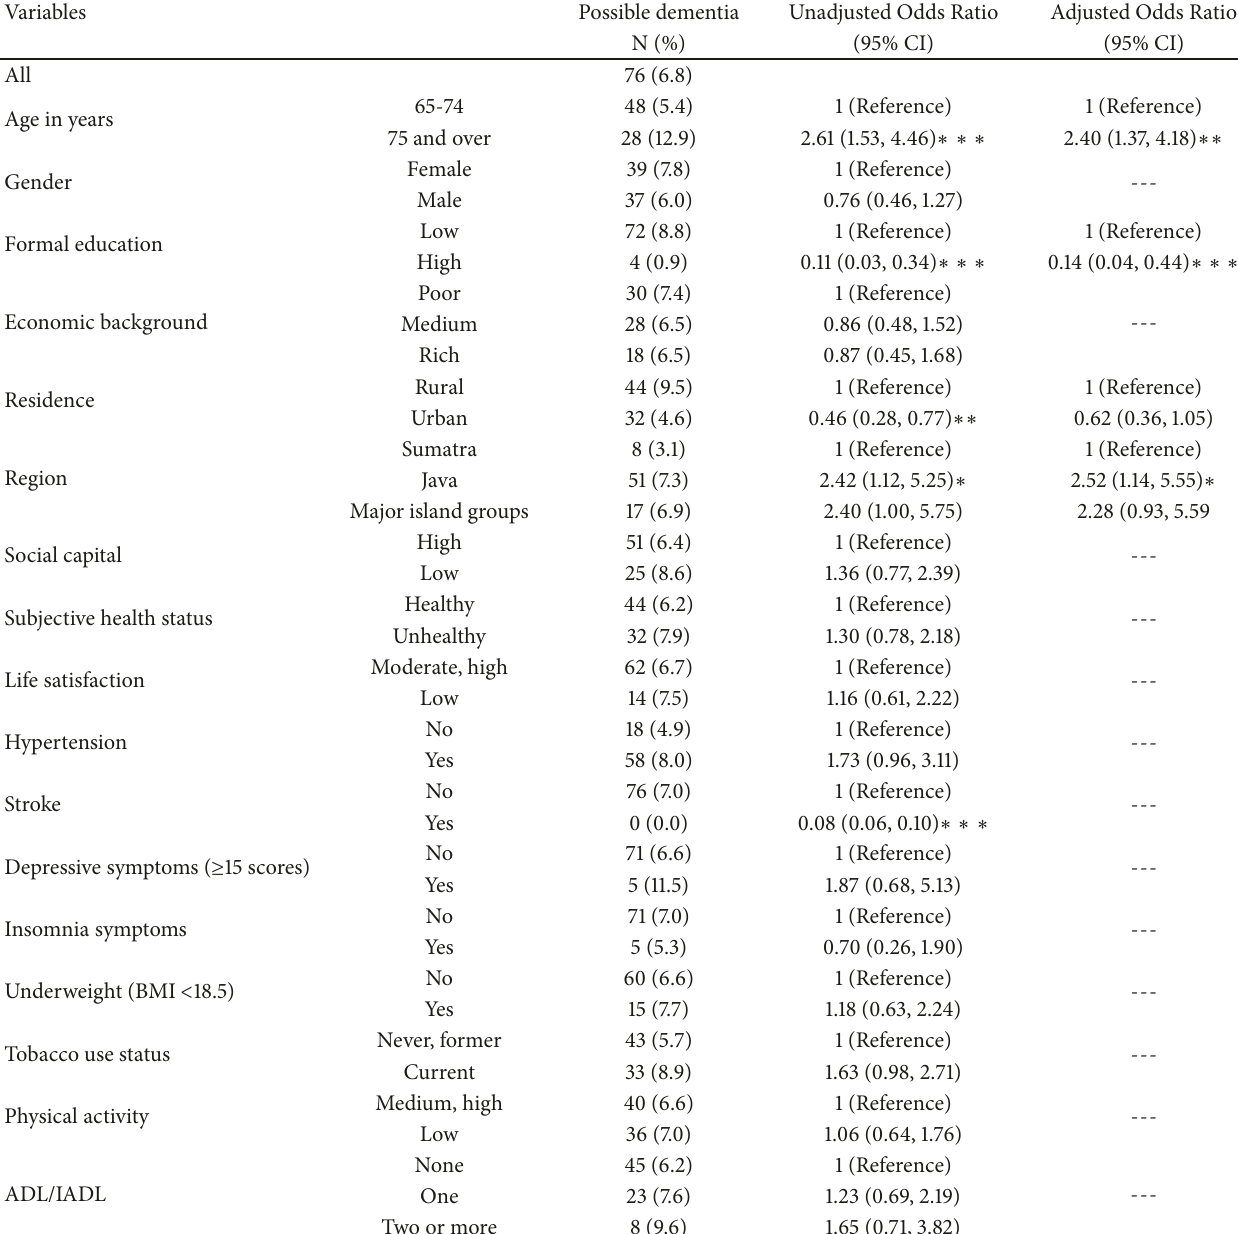
Table 3: Prevalence of possible dementia and bivariate and multivariable logistic regression with prevalence of possible dementia among older adults in